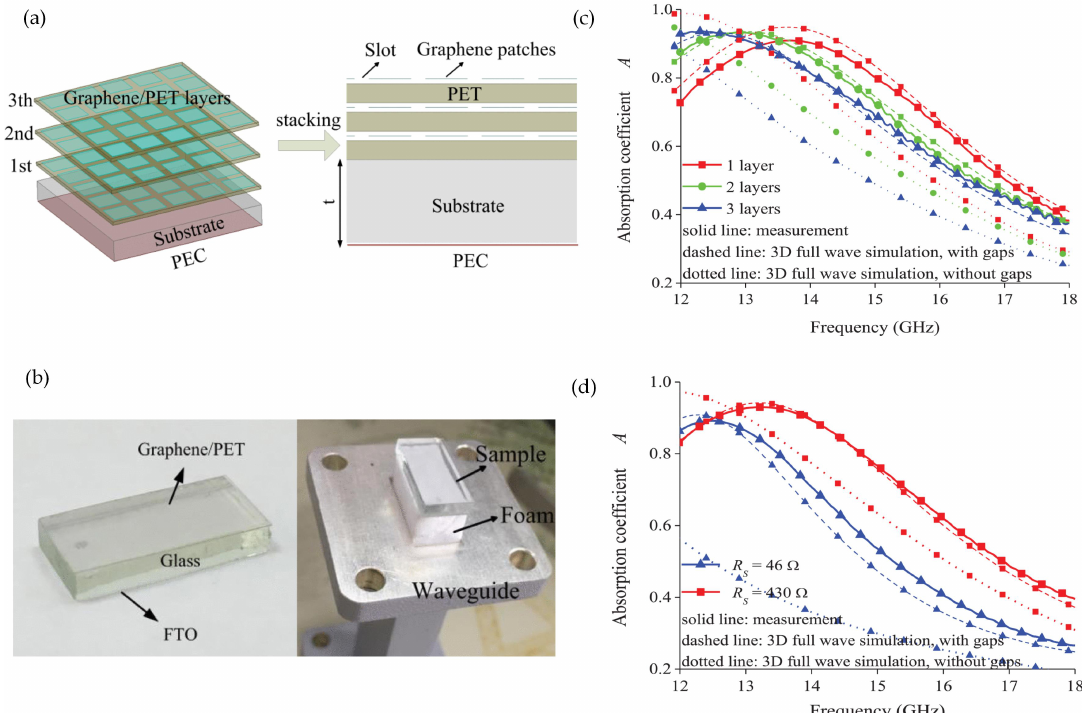
Figure 11. ( a ) schematic of the multilayer metasurface absorber with square-patterned graphene; ( b ) fabricated graphene metasurface absorber; ( c ) the measured absorption spectra for 1–3 stacked square-patterned graphene layers as well as the simulation results with and without gap between the layers; ( d ) the measured absorption spectra for a single square-patterned graphene layer but with different graphene sheet resistances and the corresponding simulation results with and without gaps between the layers, reprinted with permission from Ref.